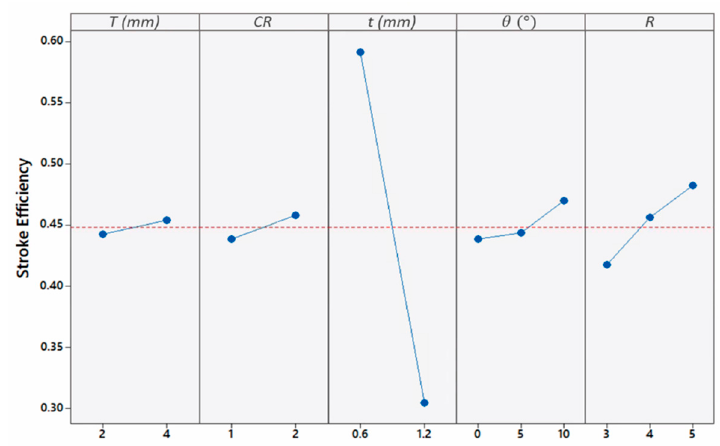
Figure 17. Influence of geometrical parameters on ε stroke .